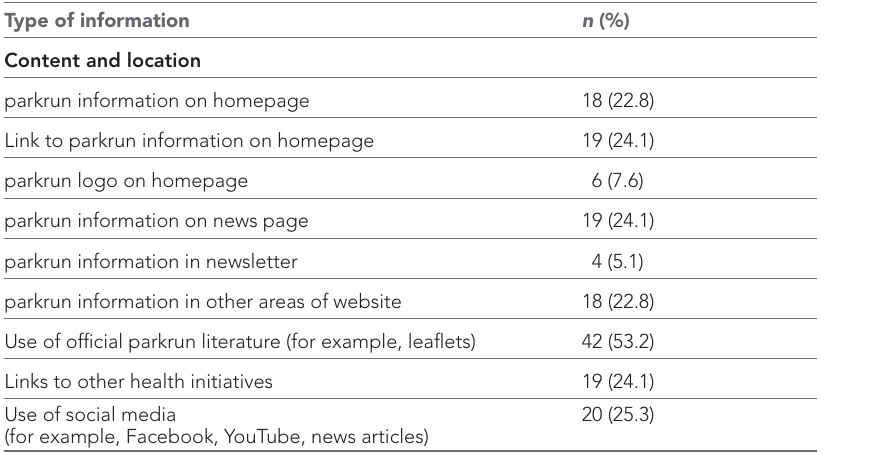
Fleming J and Mensah R. BJGP Open 2021; DOI: 10.3399/BJGPO.2020.110